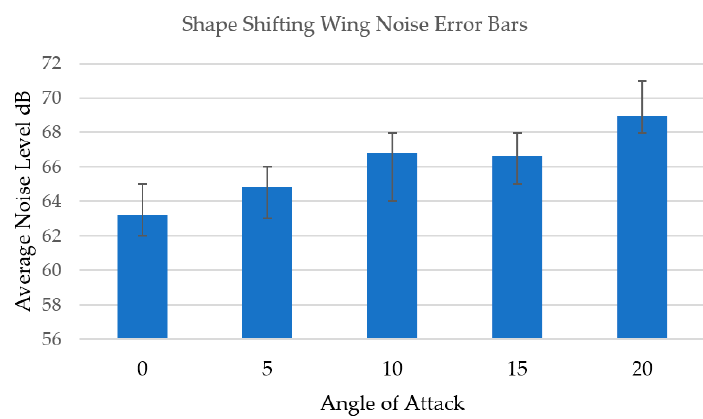
Figure 33. Shape shifting wing noise error bars.